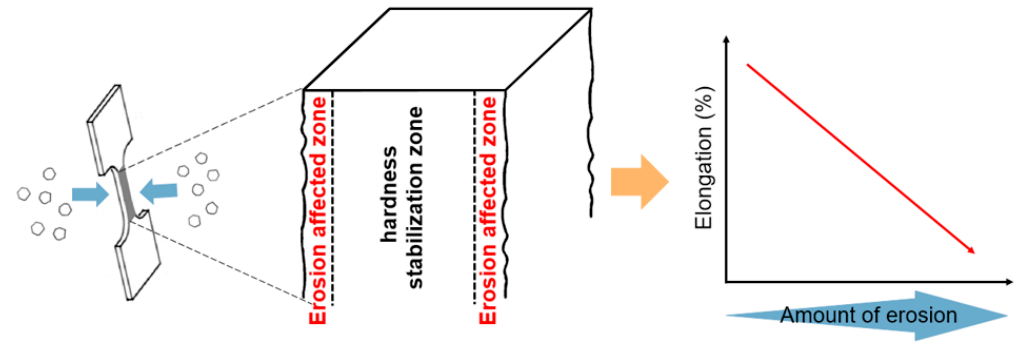
Figure 16. Decrease in ductility caused by the impact of erosion particles.